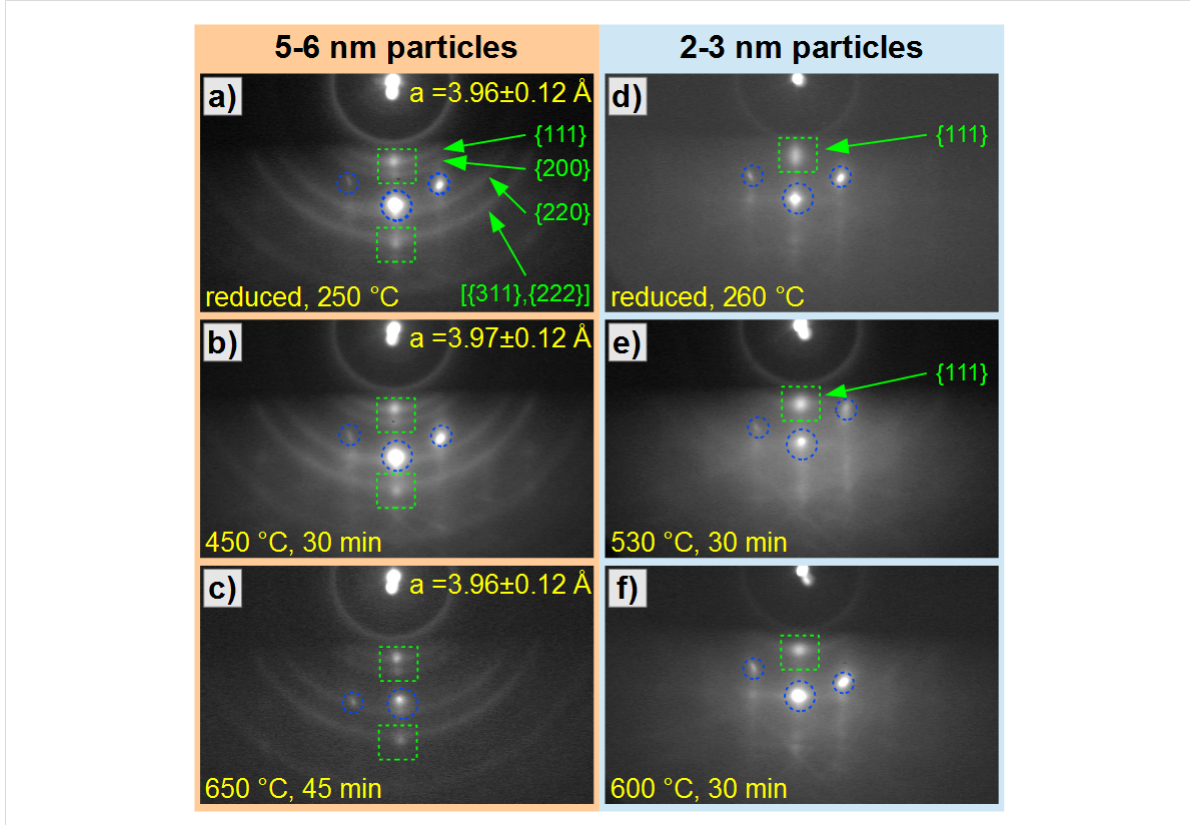
Figure 6: RHEED images of FePt NPs on sapphire(0001) single crystals after several annealing steps, recorded with an electron beam energy of 25 keV. In panels a–c the results for 5–6 nm FePt NPs present clear Debye–Scherrer rings with overlaid (111) and (222) texture spots indicated by green squares. Blue circles mark spots due to reflective diffraction of the sapphire substrate for beam incidence along the [11 − 20] direction of the sapphire surface. Annealing at 450 °C (b) and 650 °C (c) leads to no significant changes. Panels d–f present the results for 2–3 nm NPs. A dominant (111) spot with a significant vertical elongation is observed after reduction at 260 °C for 20 min. This elongation decreases after annealing at 530 °C (e) and 600 °C (f) indicating improved crystallinity. Debye–Scherrer rings are absent for the 2–3 nm FePt